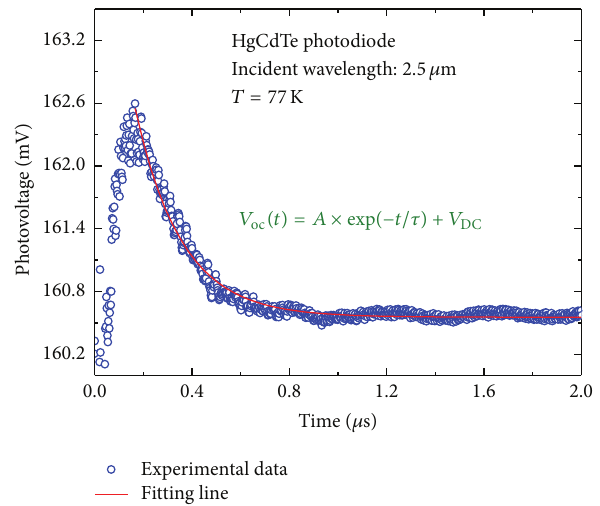
Figure 1: Photovoltaic transient profile of the HgCdTe photodiode illuminated by the laser pulses and the saturate bias light